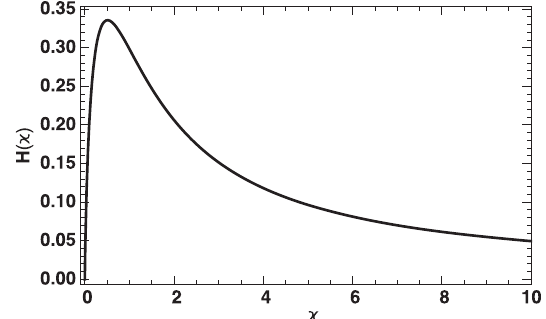
FIG. 2. Plot of function H ð ϰ Þ for positive values of the